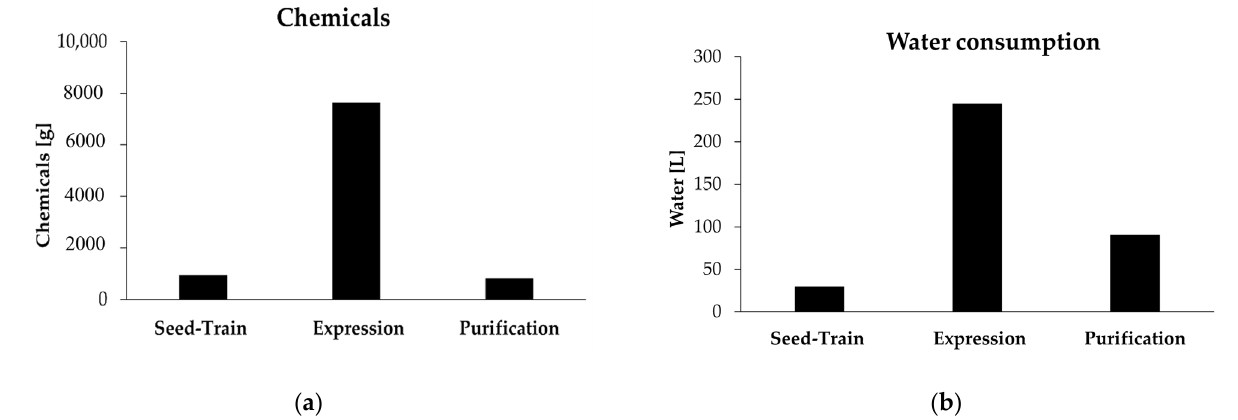
Figure 3. Consumption of chemicals and water for the production and purification of 10 g of enzyme: ( a ) amount of chemicals [g] for protein expression and purification; ( b ) water consumption [L] for protein expression and purification.